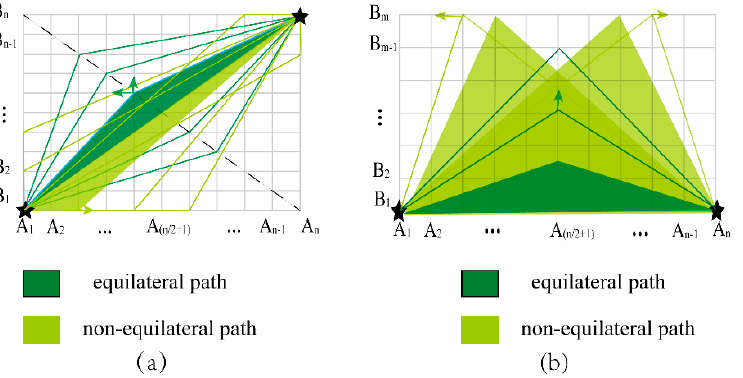
Figure 10. Schematic diagram of pre-defined three-angle paths: ( a ) the pre-defined path for two planned joints that are both motion joints, ( b ) the pre-defined path method when one of the planned joints is no motion joint.